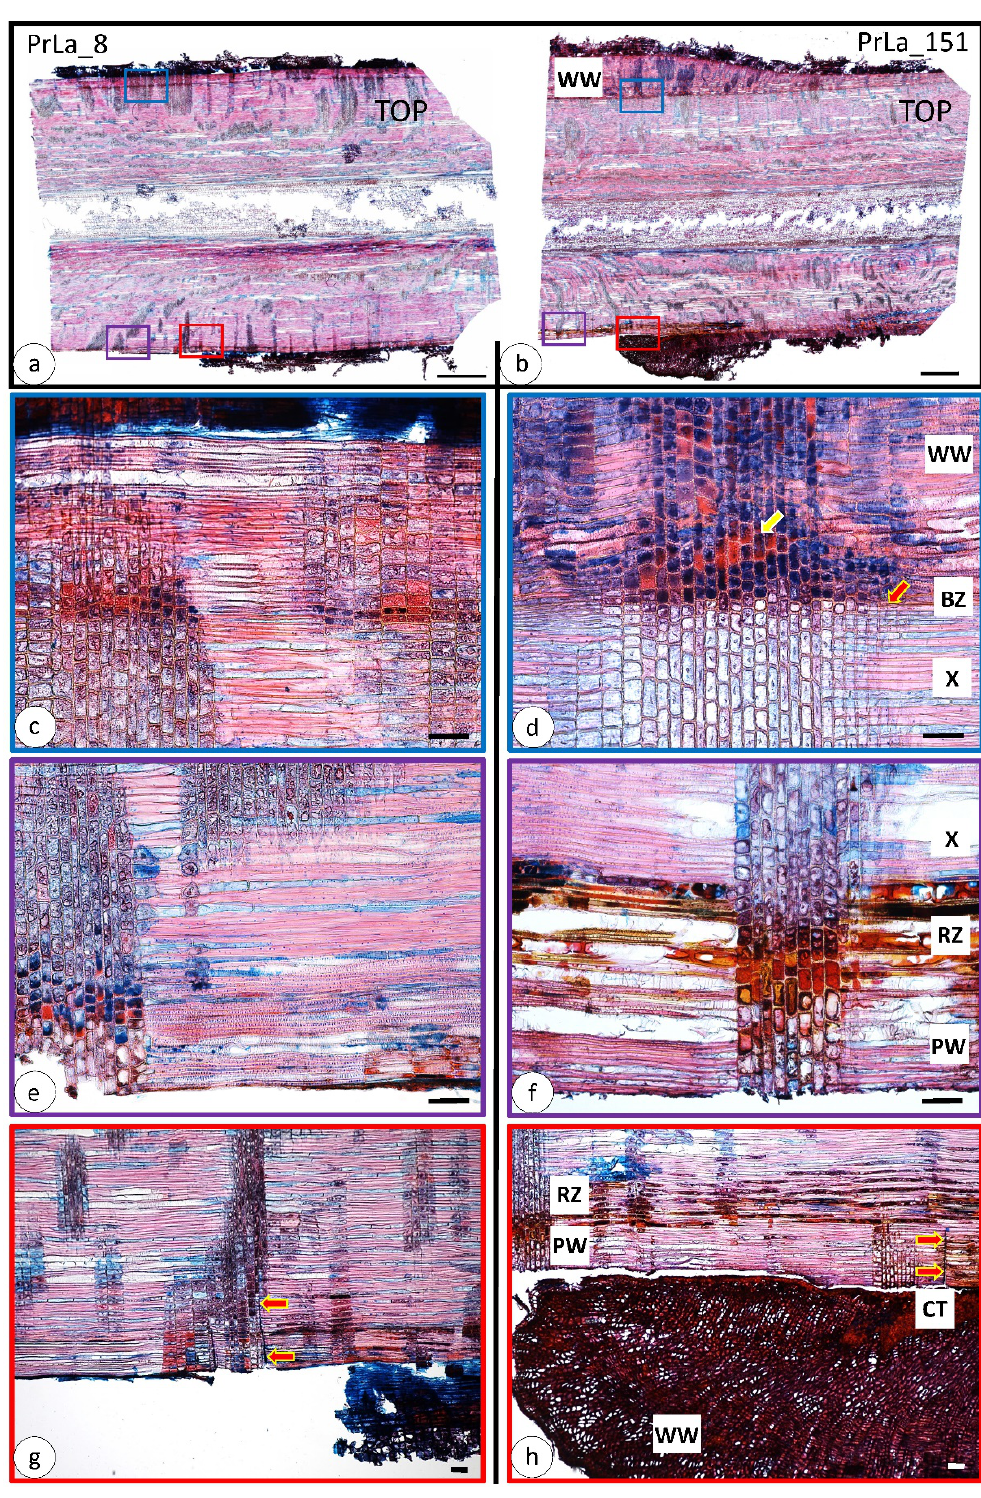
Figure 5. Cherry laurel ( Prunus laurocerasus ), radial section: ( a ) sample PrLa_8, top part (TOP), 8 days after injury; ( b ) sample PrLa_151, top part (TOP), 151 days after injury; ( c , d ) comparison of wound wood (WW), barrier zone (BZ) formation and sound secondary xylem (X) in 8 and 151 days; ( e , f ) comparison of exposed wood, reaction zone (RZ) and protection wood (PW) formation in 8 and 151 days; ( g , h ) comparison of formation of wound wood (WW), callus tissue (CT), protection wood (PW) and reaction zone (RZ) in 8 and 151 days after wounding. ROIs are marked by colour frames of the figures. Scale bars: ( a , b ) = 2 mm; ( c – h ) = 100 µm.